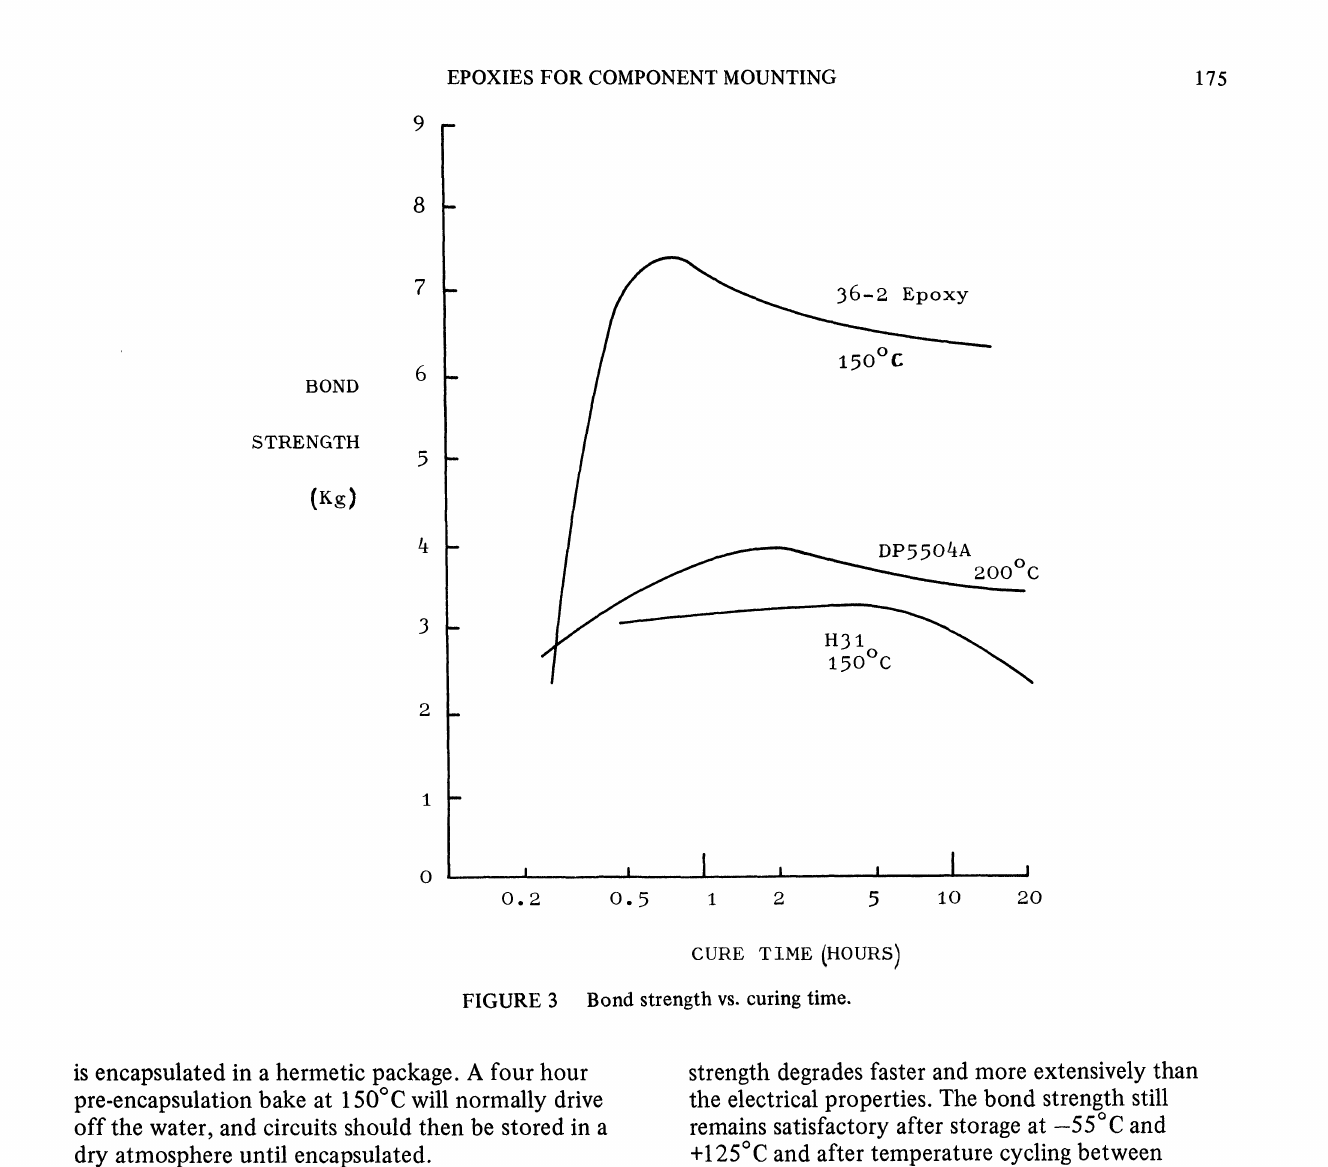
FIGURE 3 Bond strength vs. curing